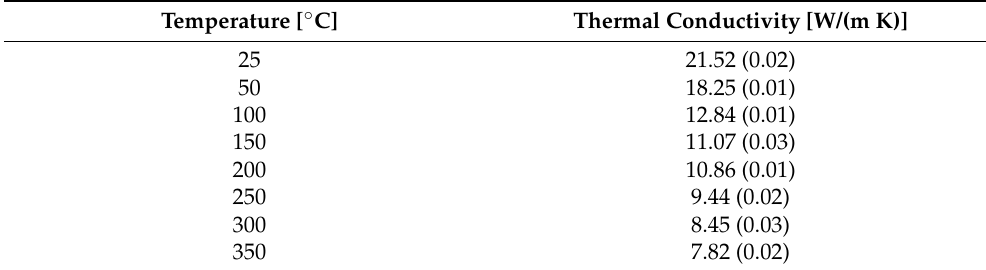
Table 6. Mean values of thermal conductivity. Standard deviations are reported in